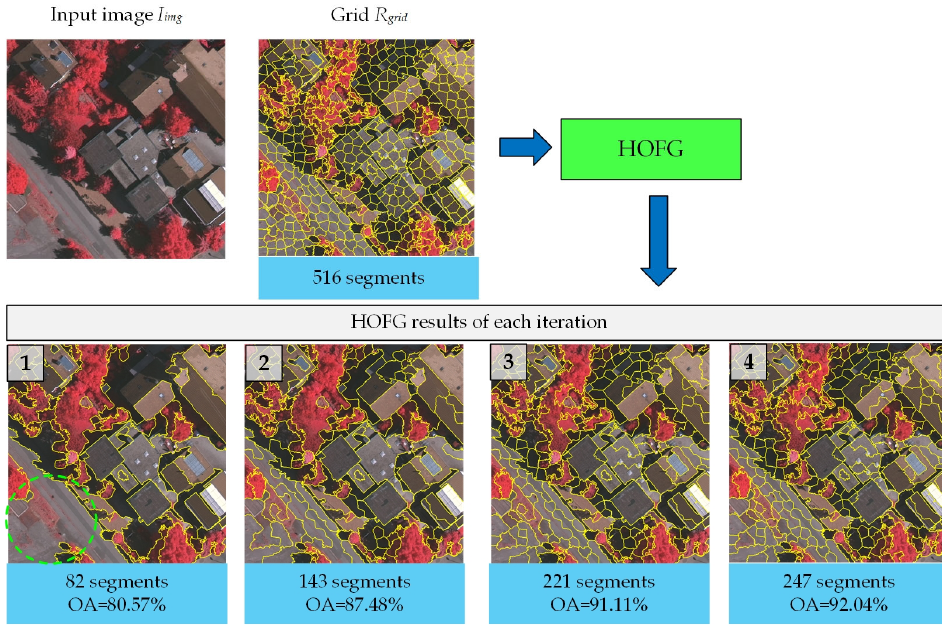
Figure 7. The iterative process of HOFG. The corresponding OA values and numbers of segments are listed in Table 3. Table 3. OA and segment number comparison of the five